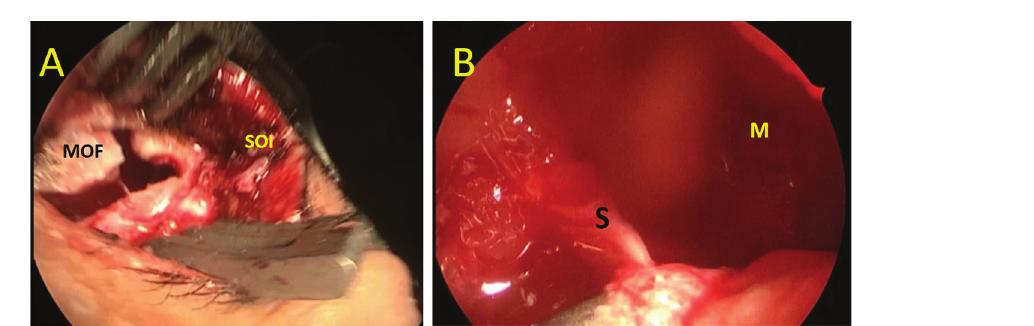
(a) Endoscopic view of left fronat asinus after removal of septum (S) and far lateral mucocele (M). (b) Endoscopic view of supraorbital incision (SOI) and in situ mini osteoplastic flap with multiportal